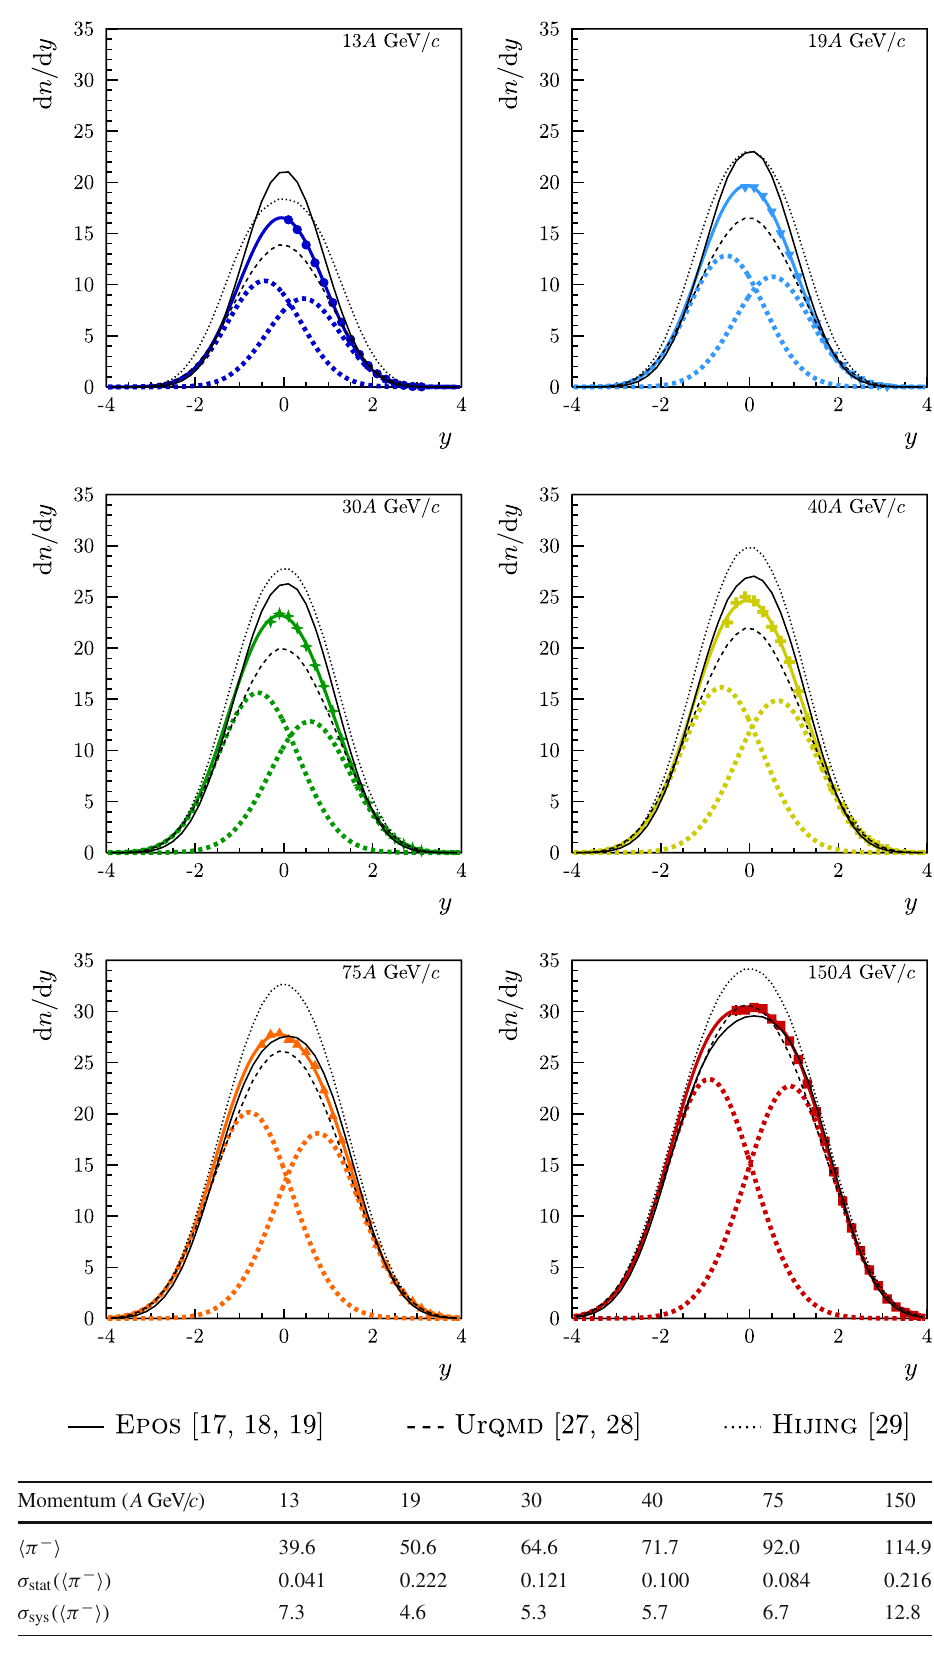
Table 4 Mean π − multiplicities in the 5% most central Ar+Sc collisions with statistical and systematic